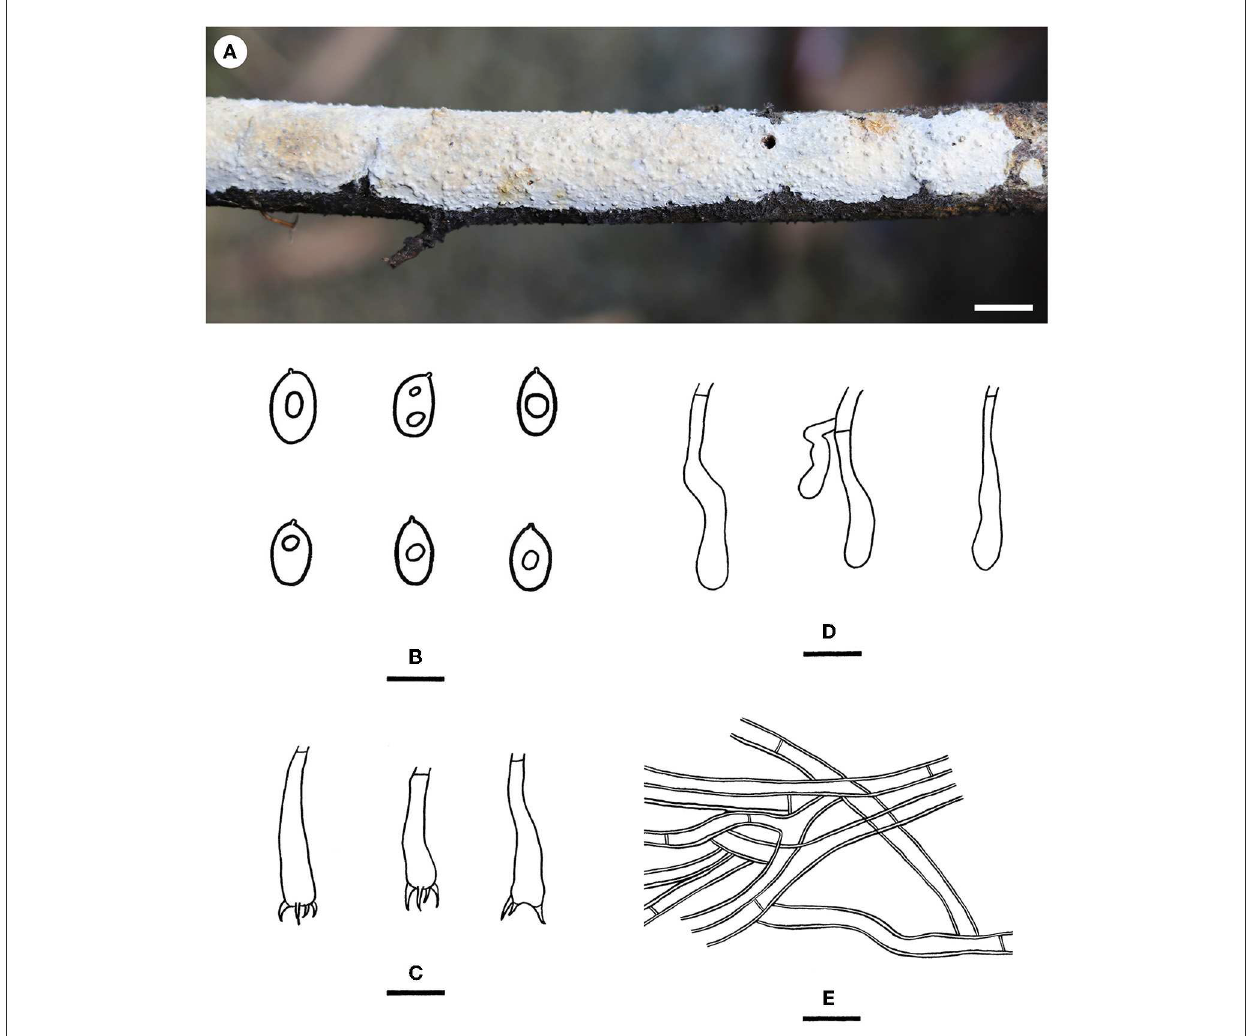
FIGURE5 Hyphodermella laevigata [from the holotype He 5427; scale bars: (A) = 1cm; (B–E) = 10 µ m]. (A) Basidiomes; (B) Basidiospores; (C) Basidia; (D) Basidioles; (E) Hyphae from